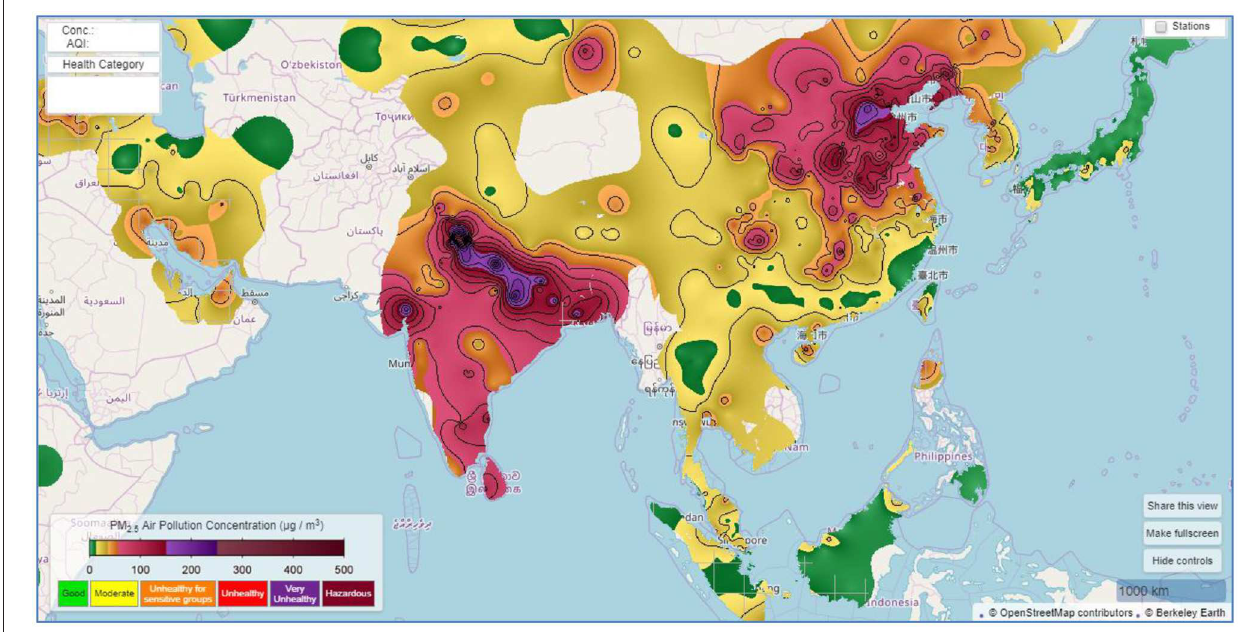
FIGURE 2 | Nearly real-time PM 2.5 map for Asia during Autumn 2018. Only the areas covered by stations are shown. Image from Berkeley Earth, www.berkeleyearth. org.